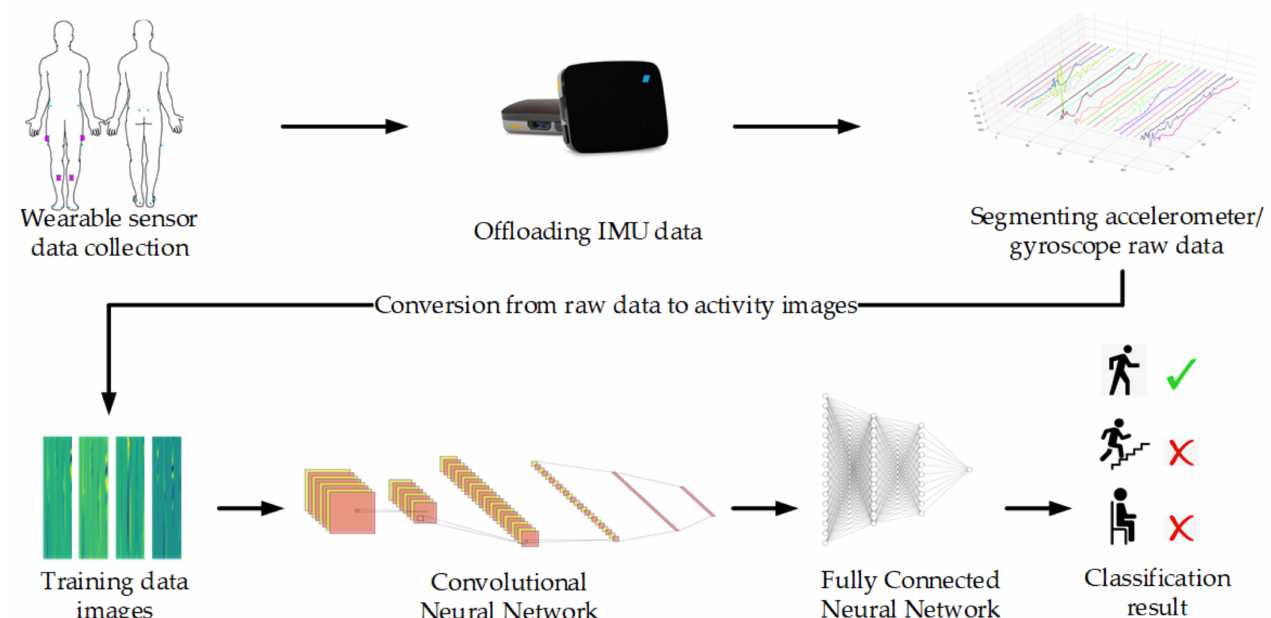
Figure 2. Architecture of the proposed human activity recognition